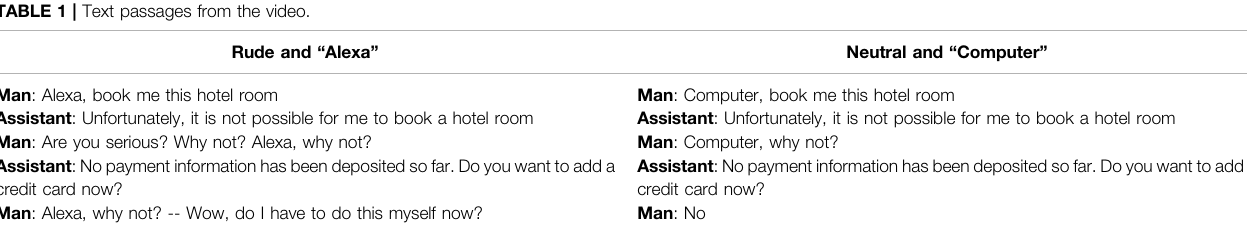
TABLE 1 | Text passages from the